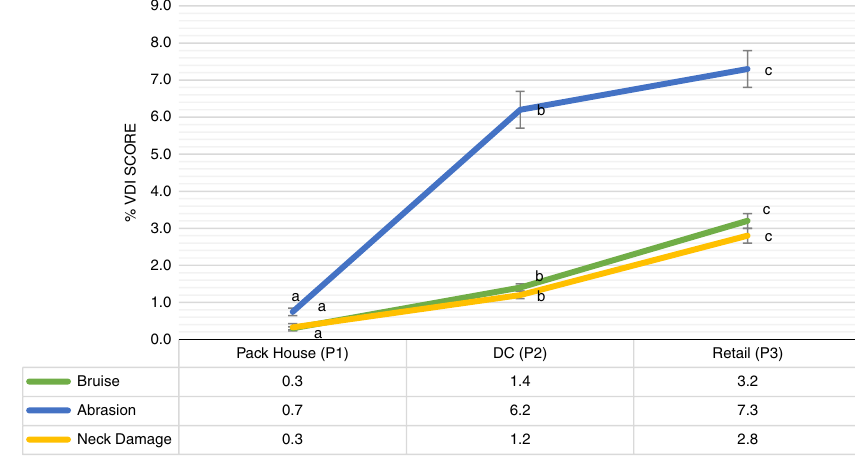
Figure 3. Progression of mechanical damages from pack house to retail